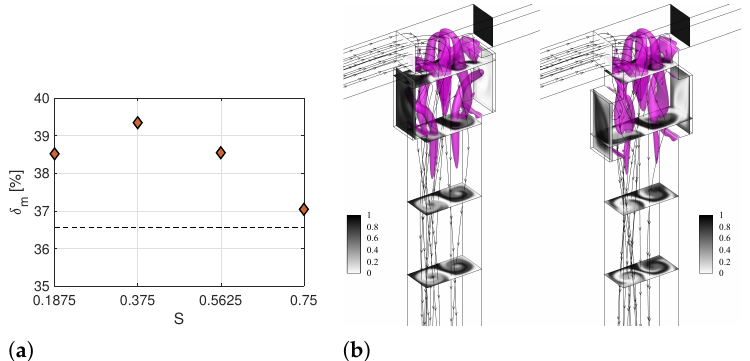
Figure 6. ( a ) Degree of mixing at the Y = − 8 cross-section of the T-microchannel with cavities located at different distance ( S ) from the junction. ( b ) Isosurfaces of the λ 2 vortex-indicator and contours of non-dimensional dye concentration at the Y = 0.375, − 1.875, − 3.375, and − 4.874 cross-sections along the outlet channel for geometries with the shortest (left panel) and longest (right panel) distance S , i.e., Case S.1 S = 0.1875 and Case S.3 S = 0.75, respectively, at Re = 200.